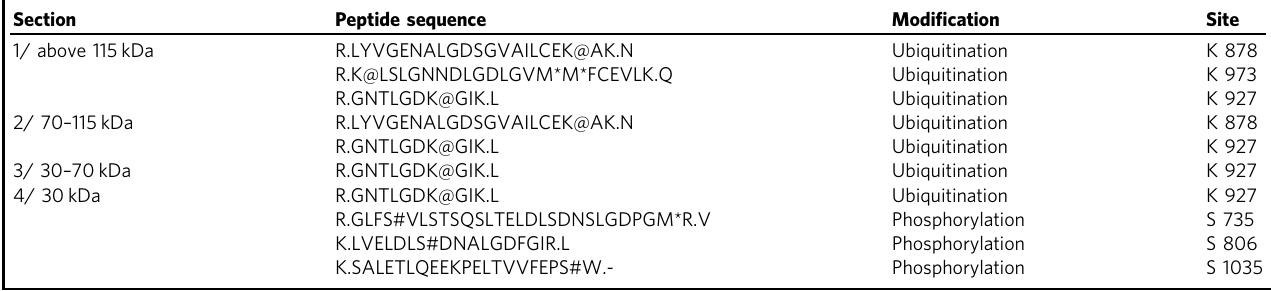
Table 1 Identi fi cation of three ubiquitination sites and three phosphorylation sites by LC-MS/MS analysis by mass